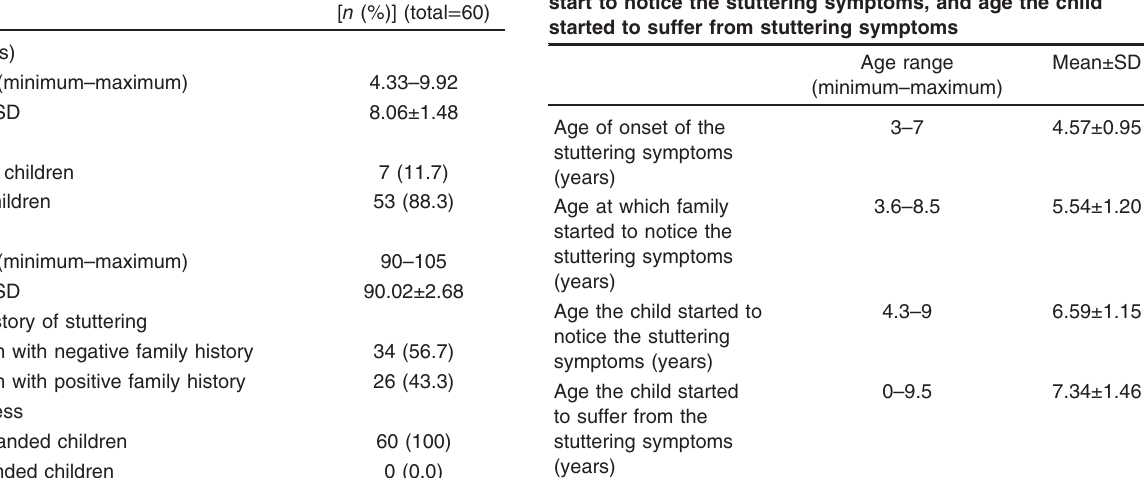
Table 1 Demographic data of participating children Demographic data